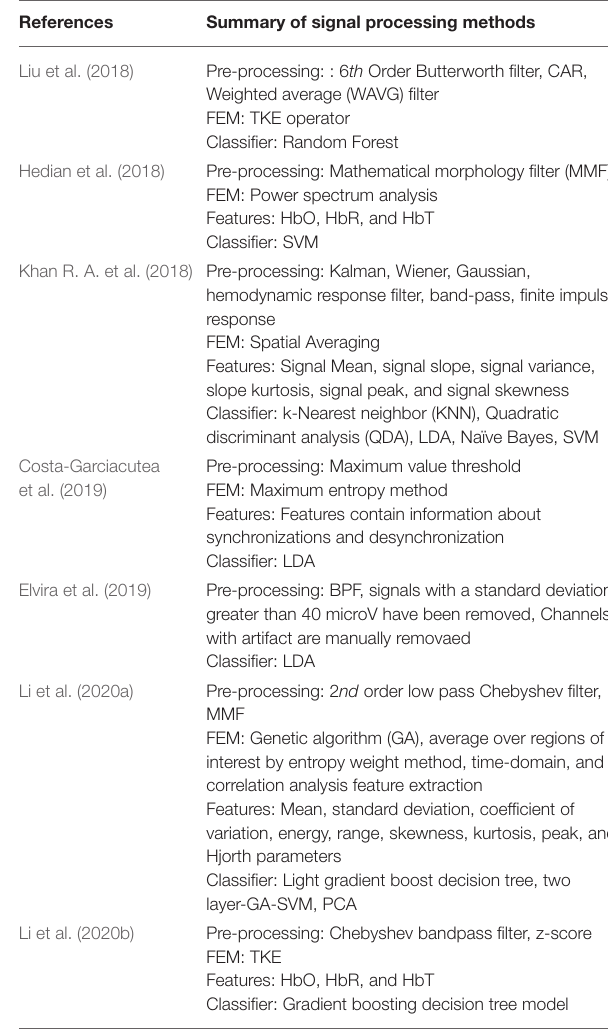
TABLE 4 | Summery of signal processing